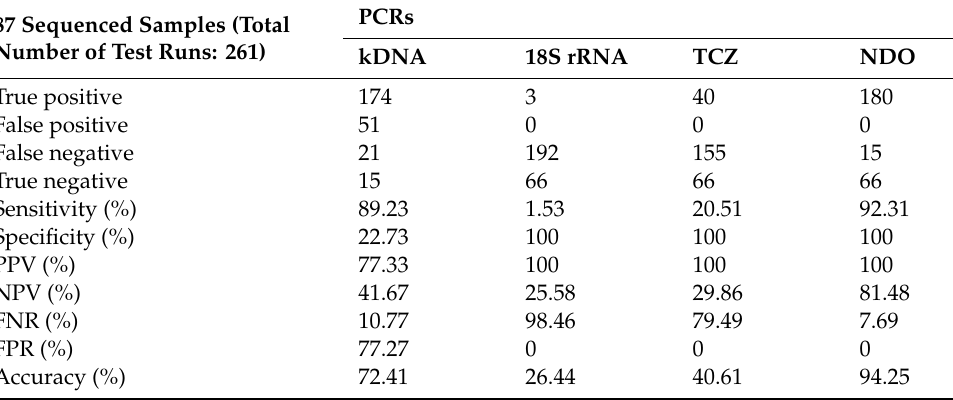
Figure 1. Immunofluorescence titer distribution in the analyzed samples.